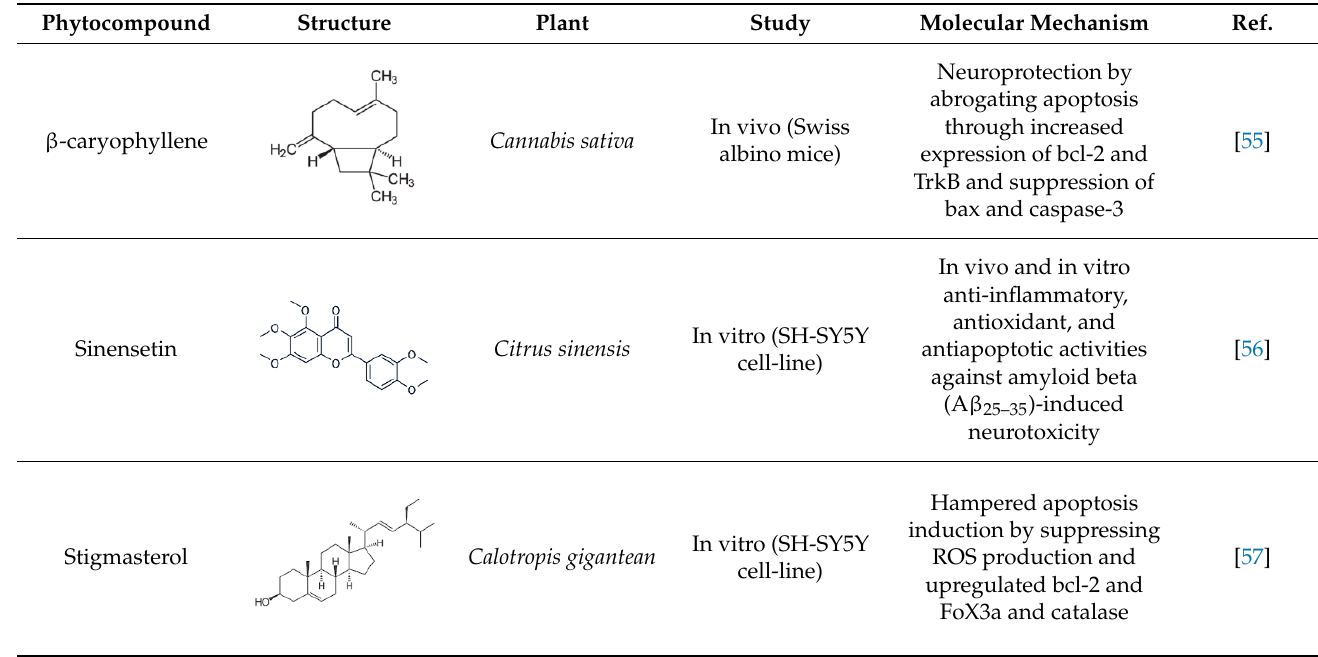
Table 2. In vitro and in vivo effects of various phytochemicals against neurodegenerative disorders.